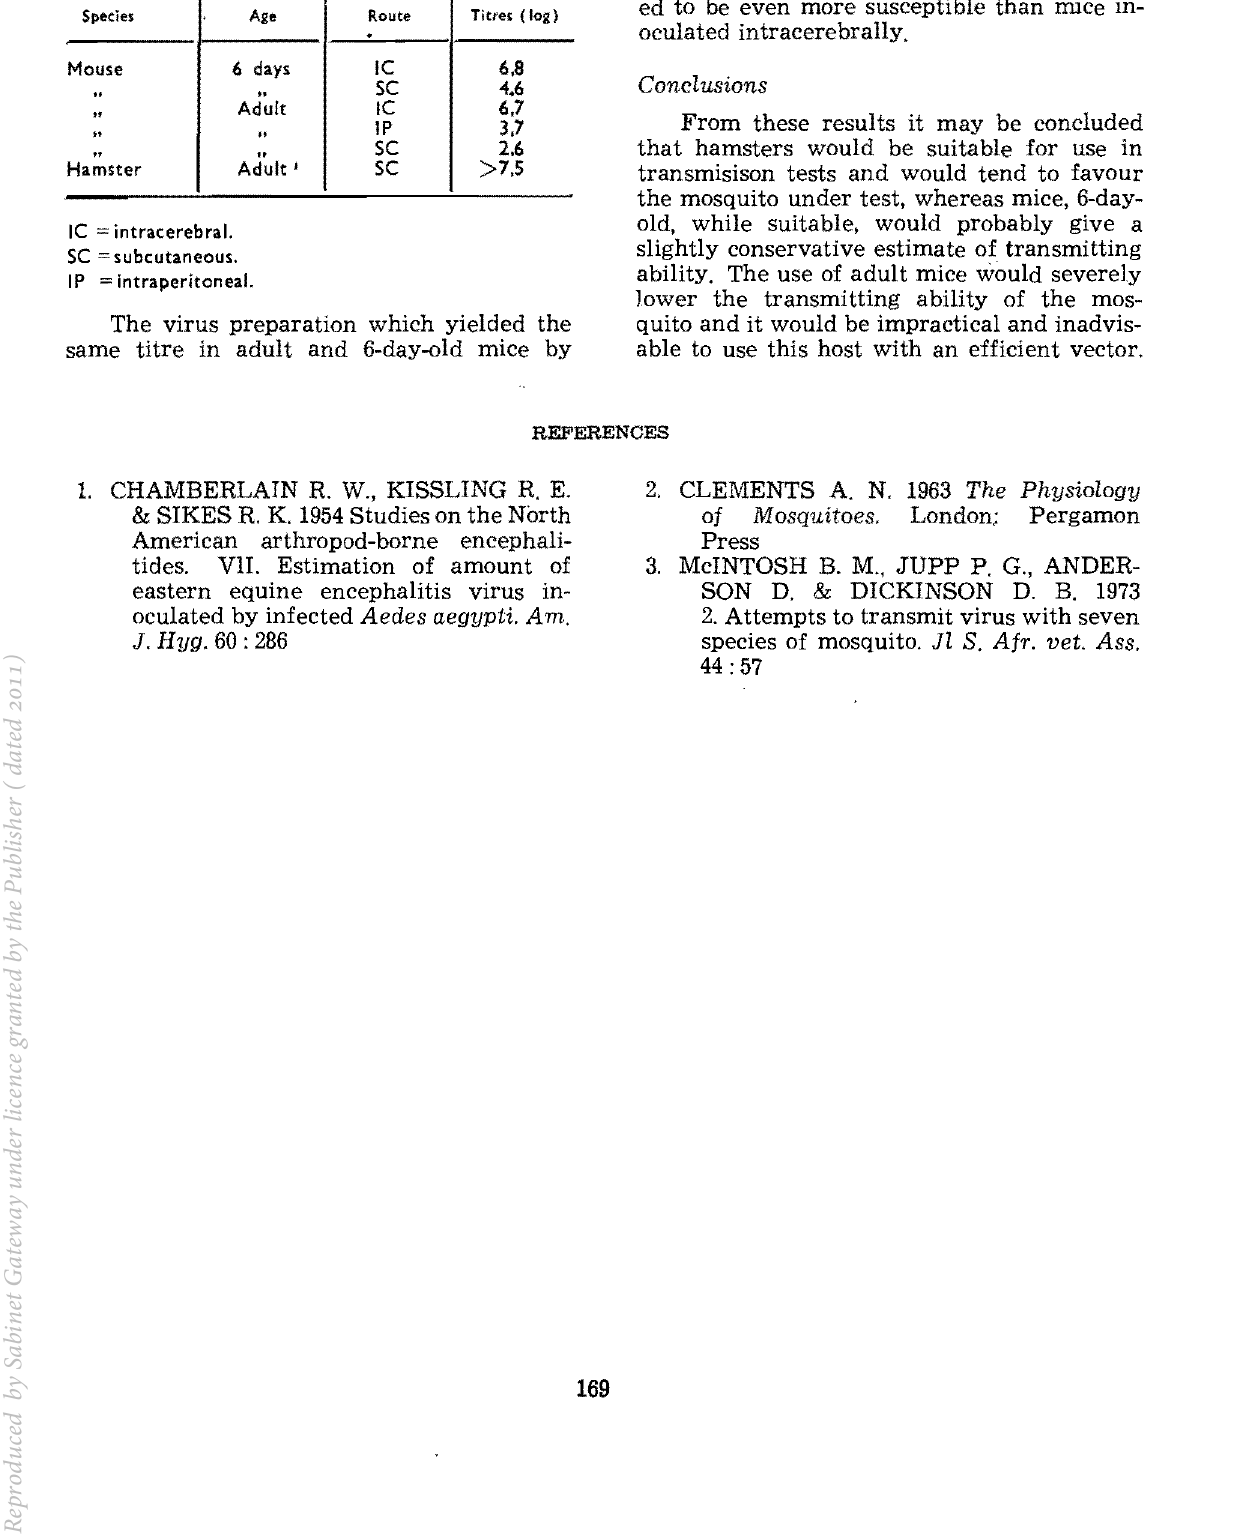
Table 2: TITRE OF THE SAME PREPARATION OF RVF VIRUS IN MICE AND HAMSTERS BY VARIOUS ROUTES OF INOCULATION Species Mouse 6 days .. Adult .. .. Hamster Adult l IC intracerebral. SC = subcutaneous. IP =